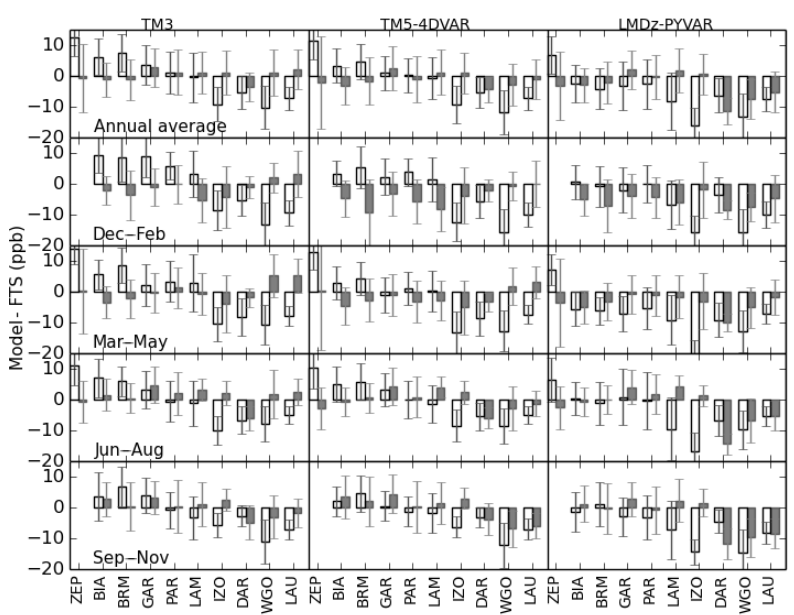
Figure 3. Yearly and seasonal medians of the scaled stratospheric and tropospheric contributions in modelled total column biases at TCCON sites. The sites from left to right are from north to south. The white bar denotes the tropospheric bias, the grey bar the stratospheric bias. The scale factors for the model bias are the air column fractions Pt / 1000 (stratosphere) and (1 − Pt / 1000) (troposphere), where Pt is the tropopause pressure. The error bars are the standard deviations of the model biases. The results are averaged for 2007–2011 when FTS measurements are